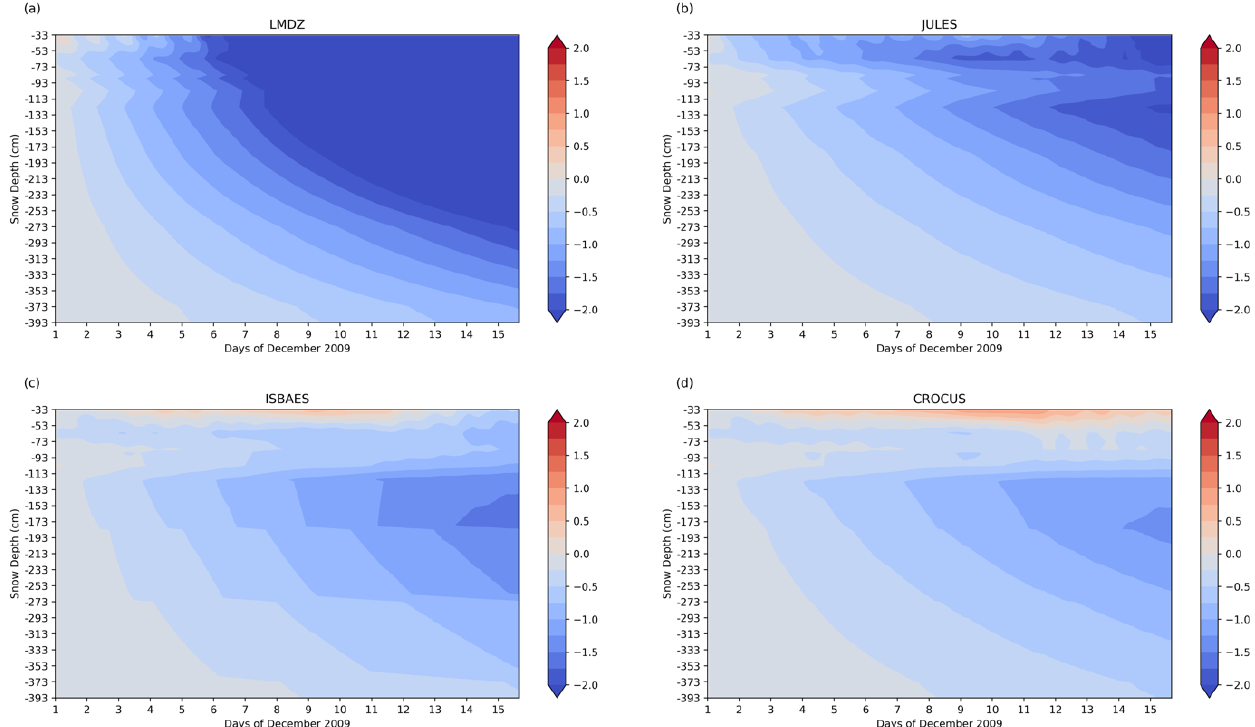
Figure 12. Temporal evolution of deviations from observations of the temperature profile in